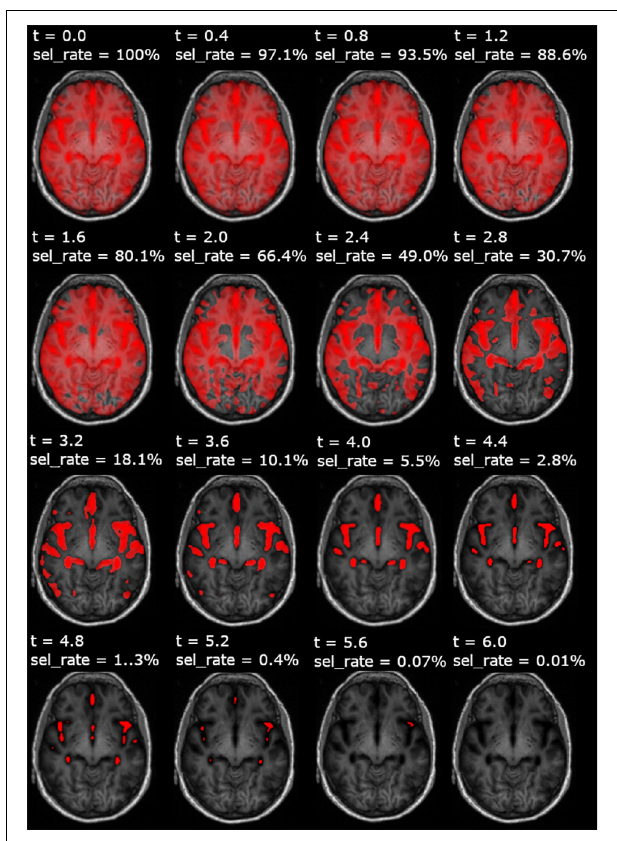
FIGURE 3 | Feature selection maps ( t -masking) overlaid on a spatially normalized axial T1-w images, for each adopted threshold ( t ). This figure represents an example resulting from a t -masking pipeline run applied to very mild AD- vs. -NC classification. For each t -masking, the fraction of voxels selected for a given threshold with respect to the whole-brain volume is also reported